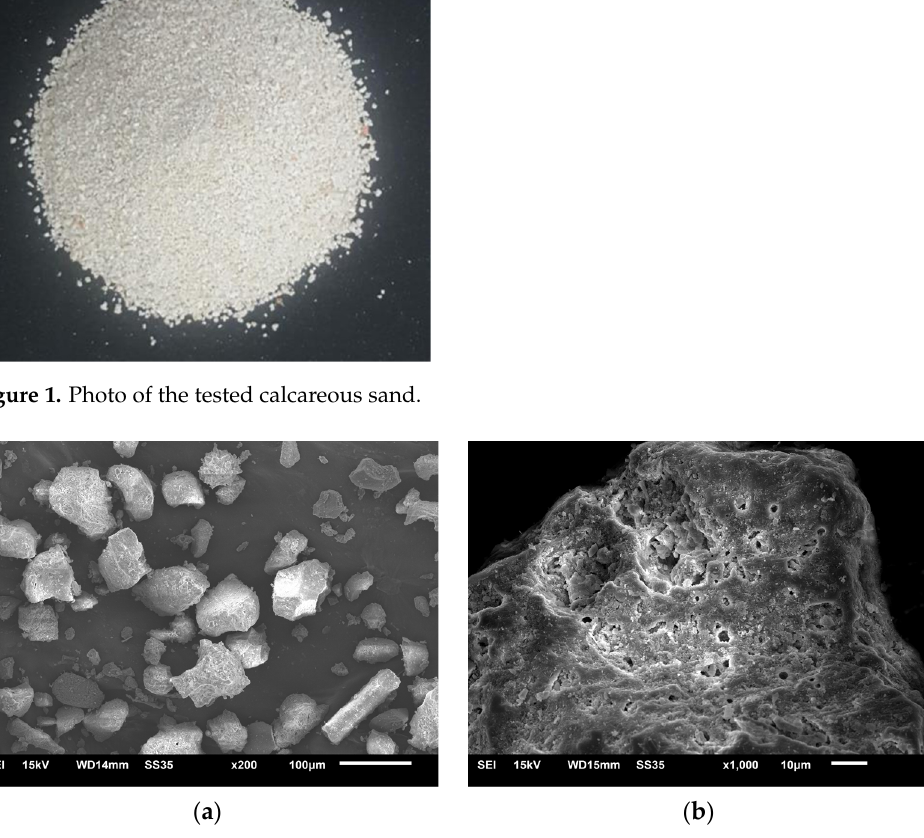
Figure 2. SEM images of the calcareous sand from the South China Sea: ( a ) × 200, ( b ) × 1000.